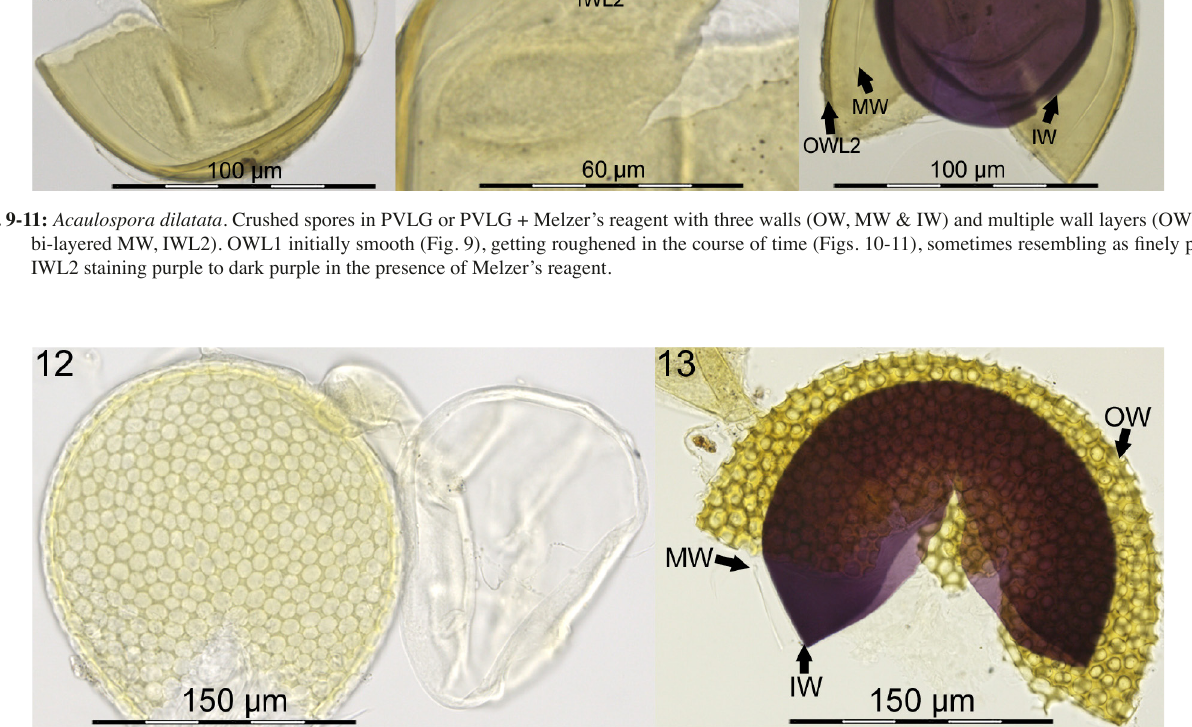
14 Spores generally < 150 μm, yellow to brownish yellow to yellow 14’ Spores generally > 150 μm, (120-)150-300 × (120-)150-520 μm, honey colored, dull brown yellow to yellow brown to olive brown . .